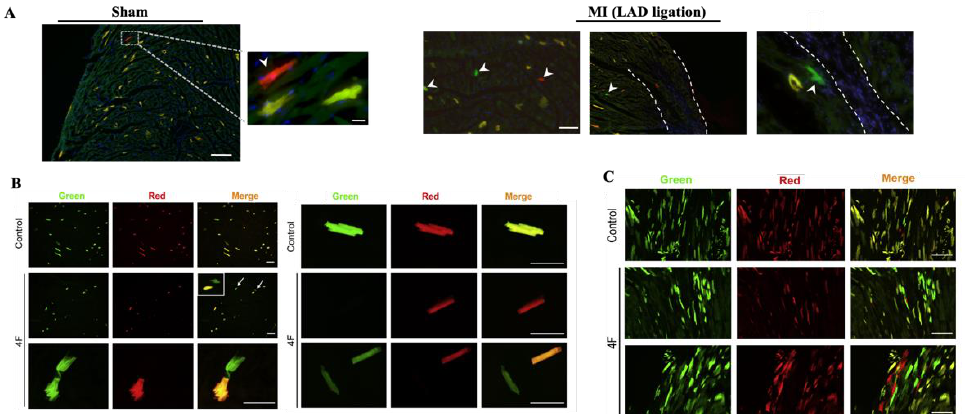
Figure 3. The utility of MADMs in studying cardiogenesis in response to acute ischemic injury: ( A ) white arrowheads point to proliferating RFP + and GFP + cardiomyocytes in Sham vs. MI, induced by LAD ligation, in the Myh6 CreERT2 ;MADM-11 GT/TG model. There was no significant increase in proliferation from Sham to MI (scale bar, 100, 20, 100, 10 µ m, from top panel to bottom panel) [25]; ( B ) immunofluorescence images showing single-positive RFP + and GFP + cells in the α MHC mERcremER ;MADM-11 GT/TG model post-4F treatment [27]; ( C ) immunofluorescence imaging from the cTnT Cre ;MADM-11 GT/TG model shows a significant increase in RFP + and GFP + cells post-4F treatment. The high number of single-positive cells can be attributed to the cTNT model labeling cells with a higher labeling efficiency and being active in the proliferative period before birth [27]; ( B , C ) adapted with permission from Ref. [27]. Copyright 2018, Copyright Elsevier.